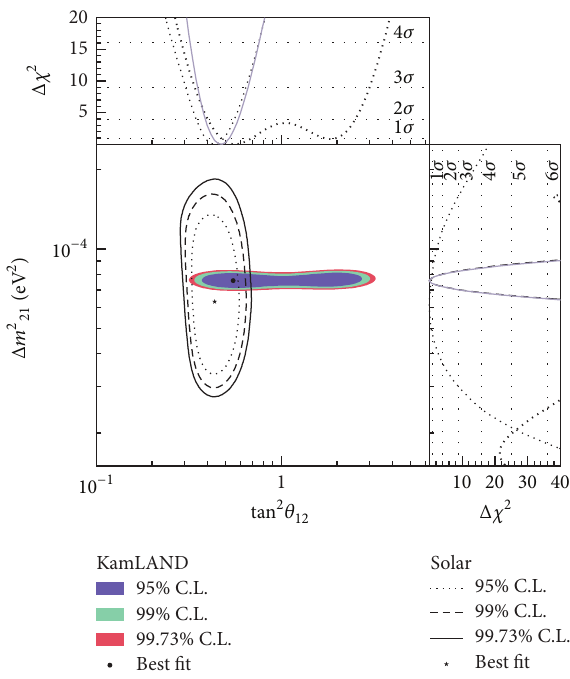
Figure 8: Allowed regions [19] for the oscillation parameters Δ𝑚 2 21 and tan 2 𝜃 12 from solar and KamLAND data. The allowed LMA area is the crossing between the solar and the KamLAND allowed